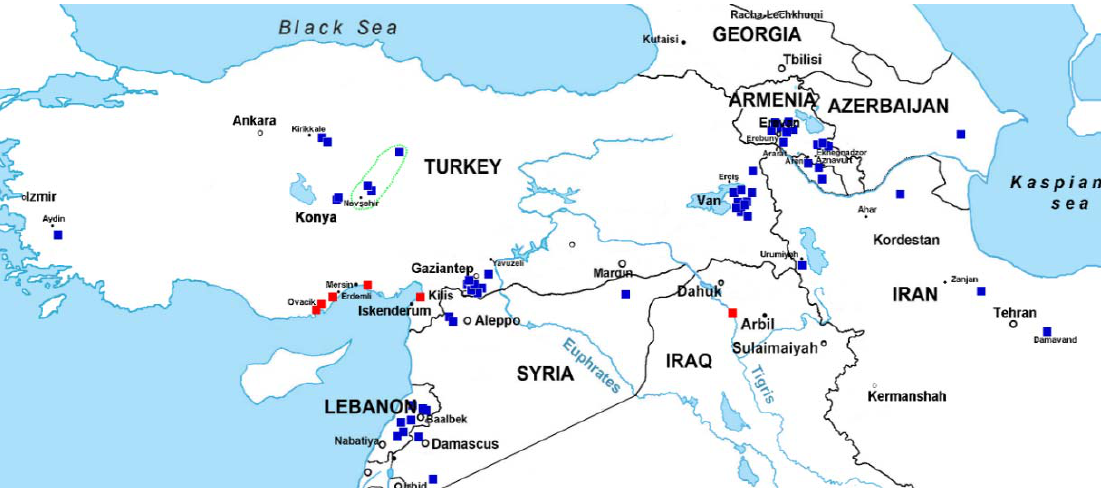
Figure 2. Geographic distribution of the C-I (blue boxes) and C-II (red boxes) accessions of Ae. columnaris with known collection sites. Accessions carrying pericentric inversion of 7U c are outlined with a green dotted line.